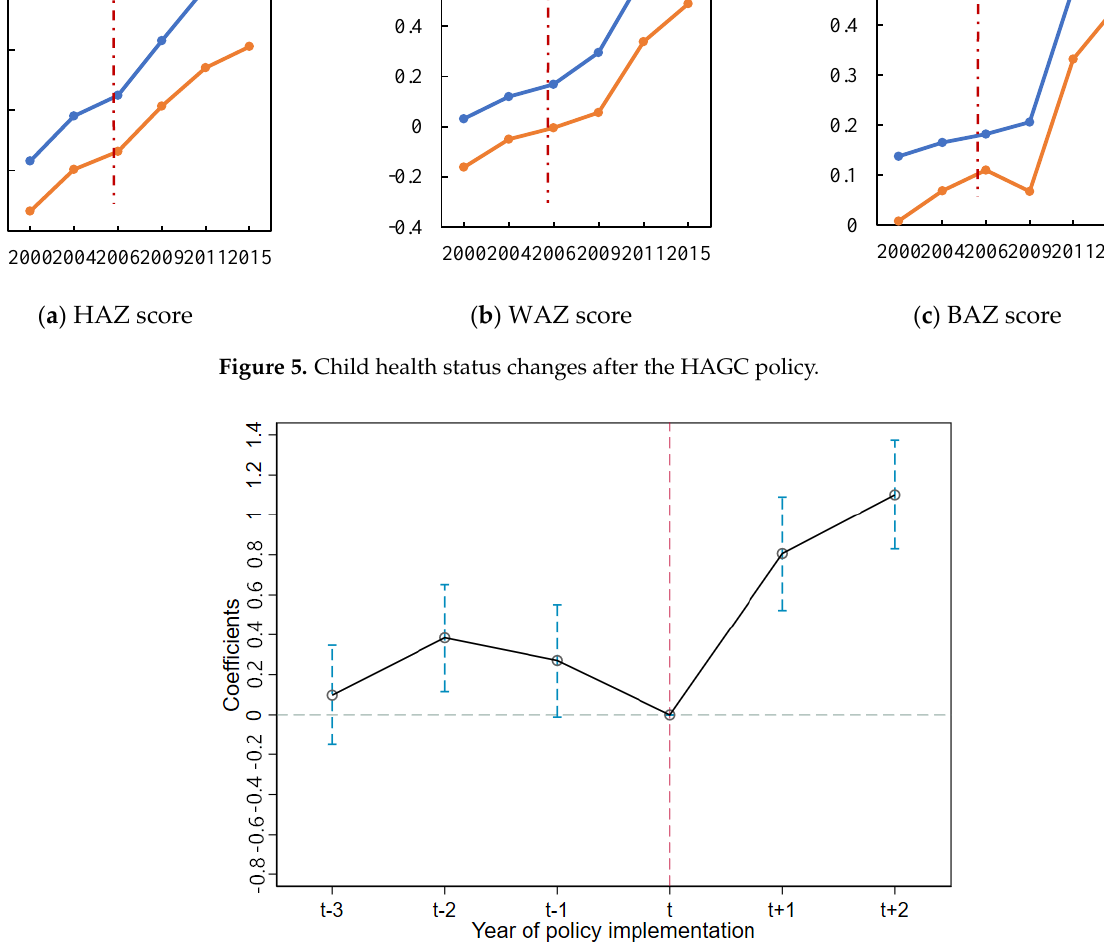
Figure 6. Effects of household technology on HAZ scores for the years before and after the treat- ment.